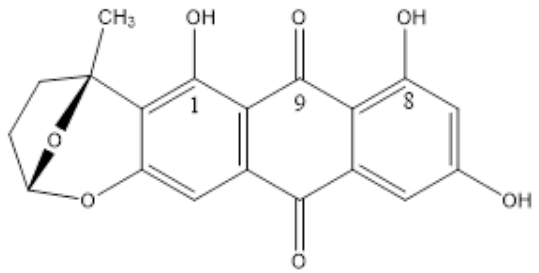
Figure 3. Tautomeric equilibrium of a β -diketone system. ( a , b ) are in fast equilibrium. ( c ) the keto form is in a slow equilibrium with the enol forms.